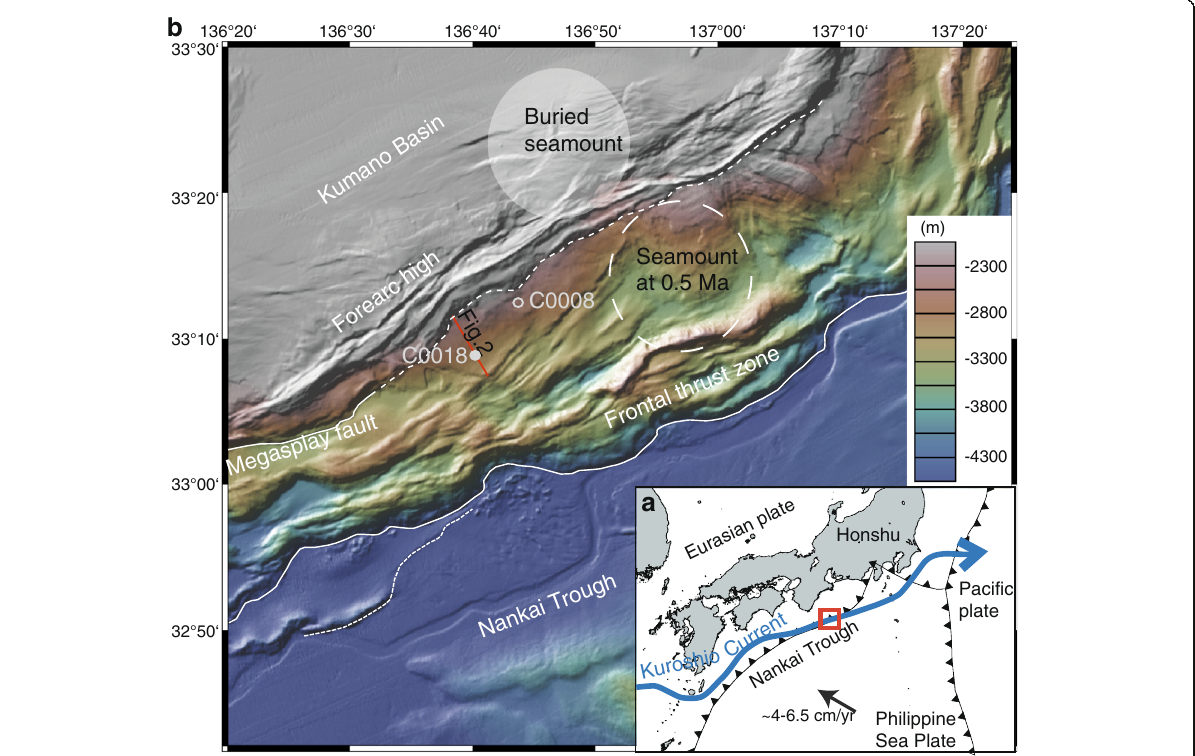
Fig. 1 Setting of the coring location in the Nankai accretionary wedge. a Overview map showing the subduction of the Philippine Sea Plate beneath the Eurasian Plate. The path of the Kuroshio Current is marked in blue . b Enlarged bathymetric map of the study site. C0018 ( gray dot ) is located in a basin downslope of the megasplay fault